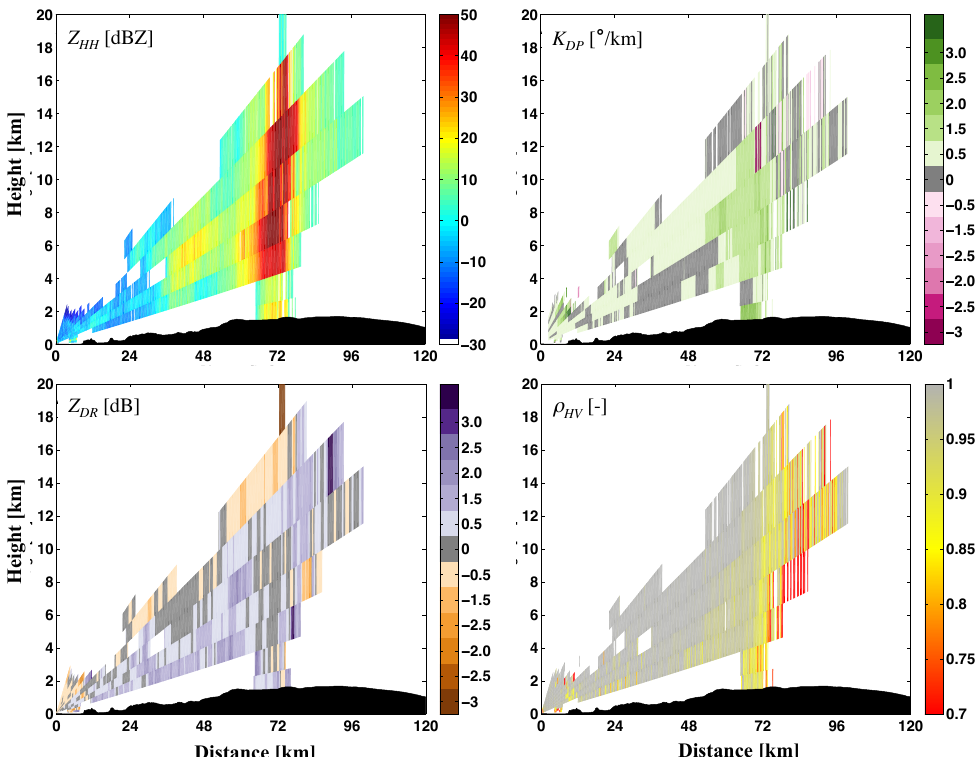
Fig. 5. As in Fig. 4 but in terms of vertical cuts of radar variables along the azimuth at 21deg clockwise from the north.